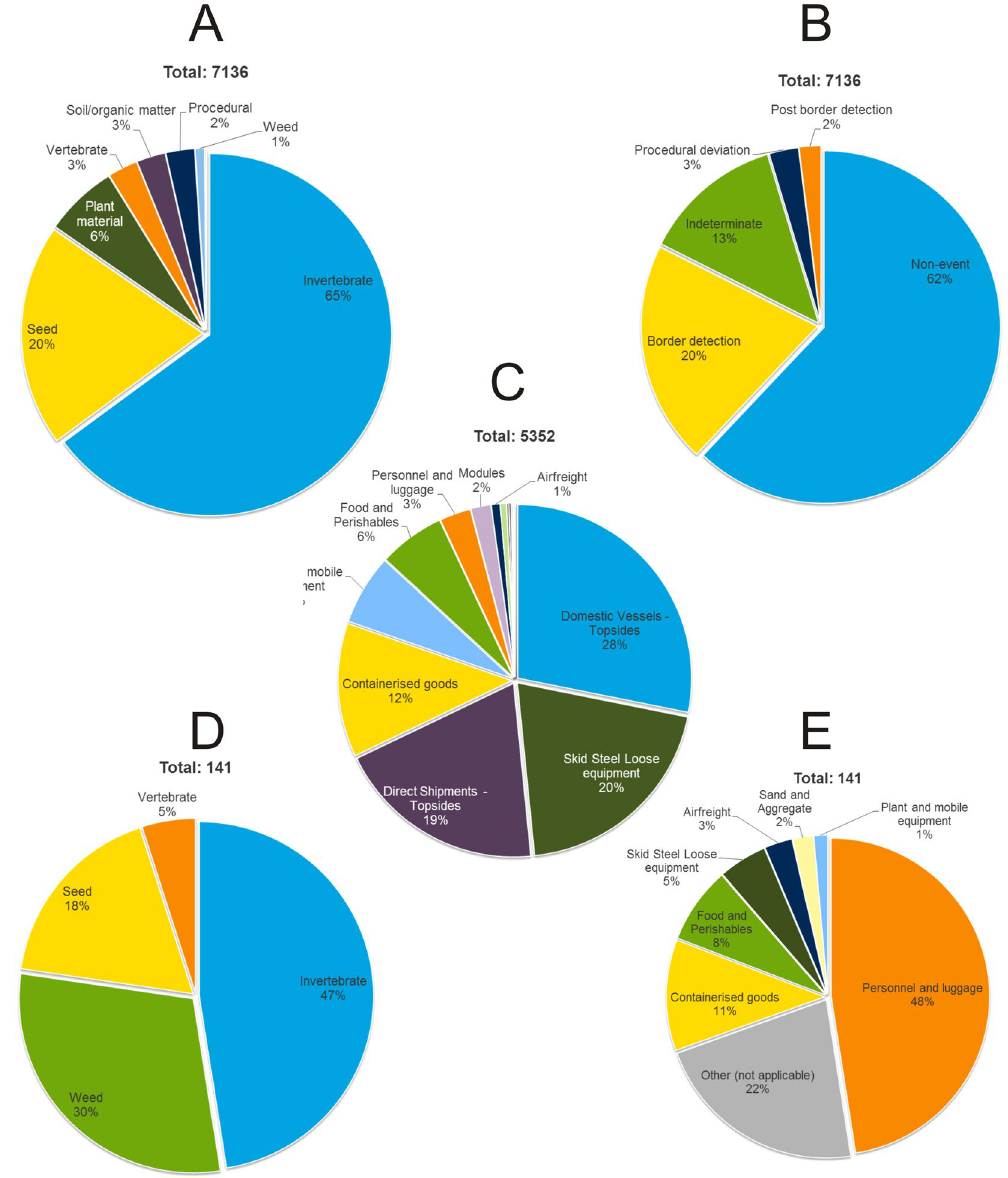
Figure 1. Percentage of border and post-border detections from September 2009 to September 2015 in different categories. ( A ) type of organism (e.g. seed) detected; ( B ) classification of detections; ( C ) detections attributed to pathways (detections that could not be attributed to a pathway were removed); ( D ) post-border detections attributed to pathways; and ( E ) organisms identified in post-border detections. Pie chart segments < 5% not labelled. For definitions of biosecurity system categories see main text and Supplementary Methods. Indeterminate refers to those specimens that could not be classified as either indigenous or